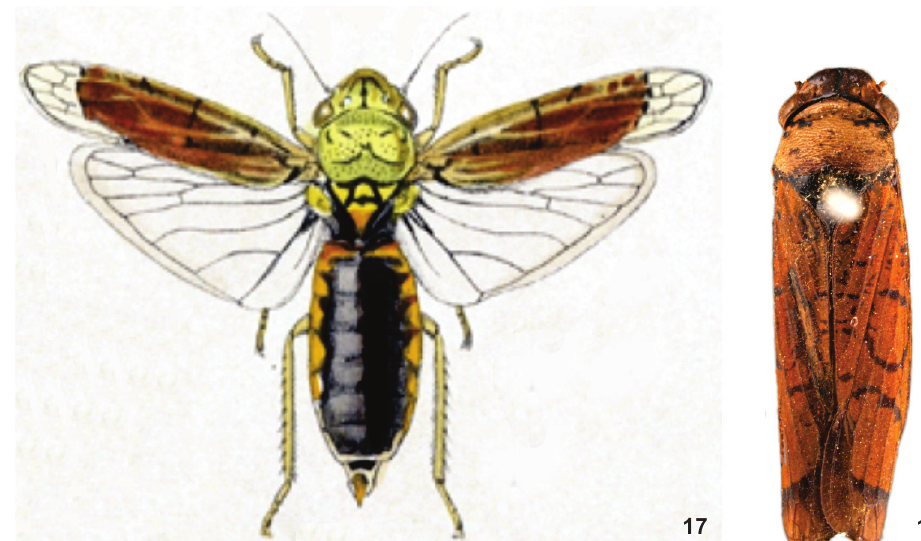
Figures 17-18. Habitus of lectotypes of Paraulacizes species, dorsal view. (17) female lectotype (length 11 mm) of Oncometopia munda (reproduced from F OWLER 1899: tab. 14, fig. 21); (18) male lectotype (length 14 mm) of Tettigonia confusa ( © Natural History Museum Vienna, Hemiptera Image Collection; published with